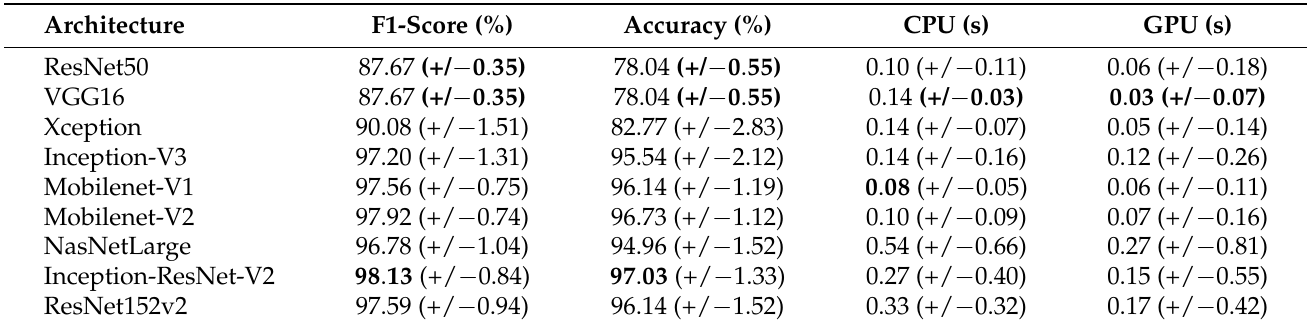
Table 3. F1-score and accuracy results of our transfer learning strategy using a support vector machine (SVM) classifier on CRINF-300 with five-fold cross-validation. The time indicates the average computational cost per individual image. Bold highlights the best